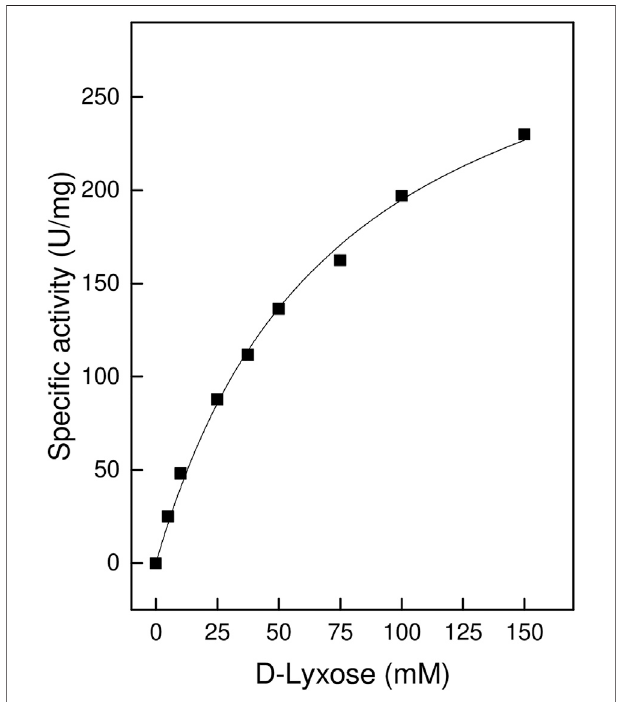
FIGURE 2 | Speci fi cactivityotTsLItowardstheD-lyxosesubstrate,relative to the D-lyxose concentration. The assays (600 µL) were performed at 95 ° C in 50 mM BisTris buffer, pH 7.0, containing 1 mM MnCl 2 and 6.7 µg enzyme. The kinetic constants were fi tted to the Michaelis-Menten equation using the calculated standard errors; the Vmax and Km values were 338 ± 14.9 U/mg and 73 ± 6.6 mM, respectively.